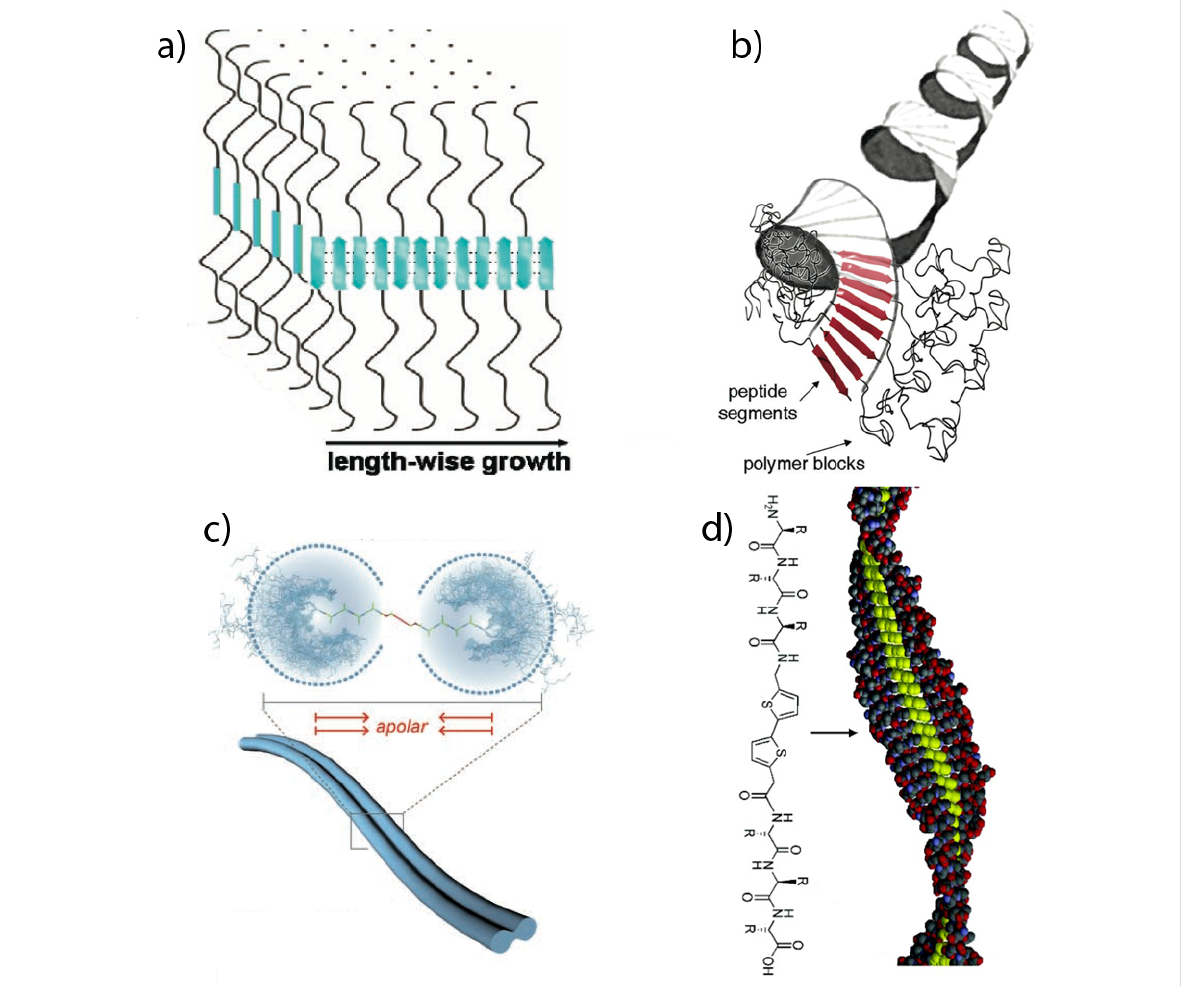
Figure 1: Various morphological organization examples of fibrillar aggregates that can be formed by polymer bioconjugates: (a) Wide planar tapes [18]; (b) helical superstructure [19]; (c) tapes with a dumb-bell shaped cross section [20]; (d) helical tapes with a thiophene block in the middle